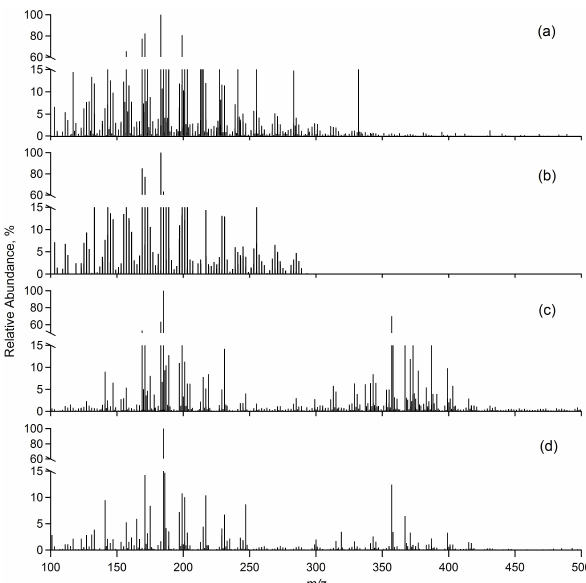
Fig. 1. Direct infusion negative-nanoESI-Orbitrap mass spectra obtained for representative OA samples from (a) boreal forest, Hyytiälä, Finland collected on 17 August (night-time), (b) boreal forest, Hyytiälä showing only “common” ions that are present in all 10 samples (see text for detailed explanation), (c) α -pinene/O 3 ex- periments and (d) BVOC mixture/O 3 experiments. For clarity, the most intense peak at m/z 212.0751 has been removed and mass spectra (a) and (b) have been normalised to the second most in- tense ion at m/z 185.0818. The mass spectrum for SOA from the BVOC mixture/O 3 has been scaled up to display all ions that were suppressed by the most intense ion at m/z